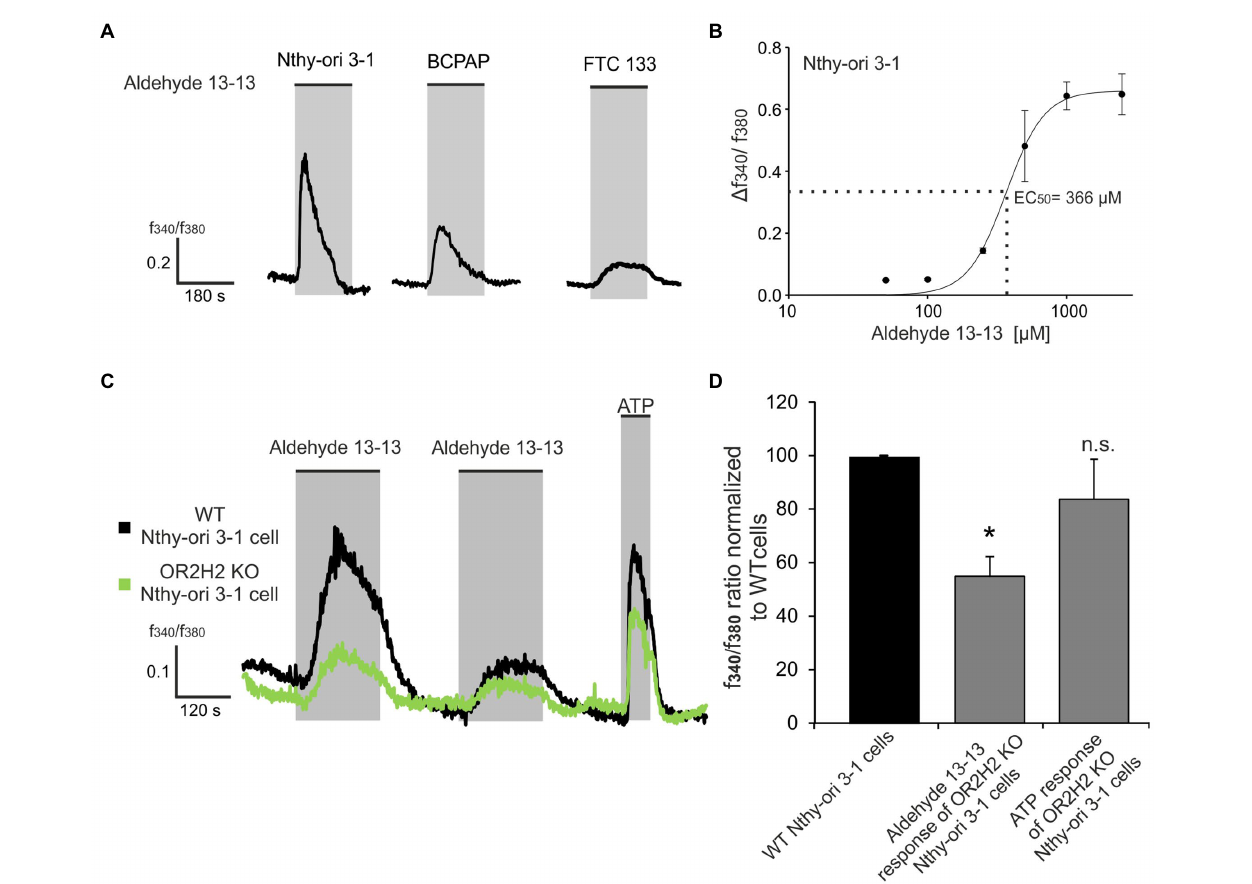
FIGURE 3 | Aldehyde 13-13 mediates an increase of the intracellular Ca 2+ concentration by the stimulation of OR2H2 in Nthy-ori 3-1 cells. (A) Exemplary traces of Ca 2+ responses induced by stimulation with 500 μ M aldehyde 13-13 in the thyroid cell lines. (B) The dose-response curve was prepared for the Nthy-ori 3-1 cell line. The calculated fluorescence ratio of f 340 / f 380 (magnitude) was plotted against the aldehyde 13-13 concentration. The curve was fitted using Hill’s 3rd equation. The half-maximum Ca 2+ increase occurred at a concentration of 366 μ M aldehyde 13-13. (C) Exemplary Ca 2+ imaging traces of Nthy-ori 3-1 cells transfected with CRISPR/Cas9 system for a knockout of the OR2H2 gene (KO, green) and wild type cells (WT, black). Cells were stimulated with aldehyde 13-13 (500 μ M) and ATP (100 μ M) as control. (D) The magnitudes of the Ca 2+ response of transfected cells were normalized to the WT cells in the same measurement. The mean values are shown with the corresponding SEM. Data significance was calculated by comparing aldehyde 13-13 or ATP induced magnitudes of KO with WT Nthy-ori 3-1 cells using Wilcoxon matched-pairs signed-rank test. n = 6–9, * p ≤ 0.05, n.s. = not